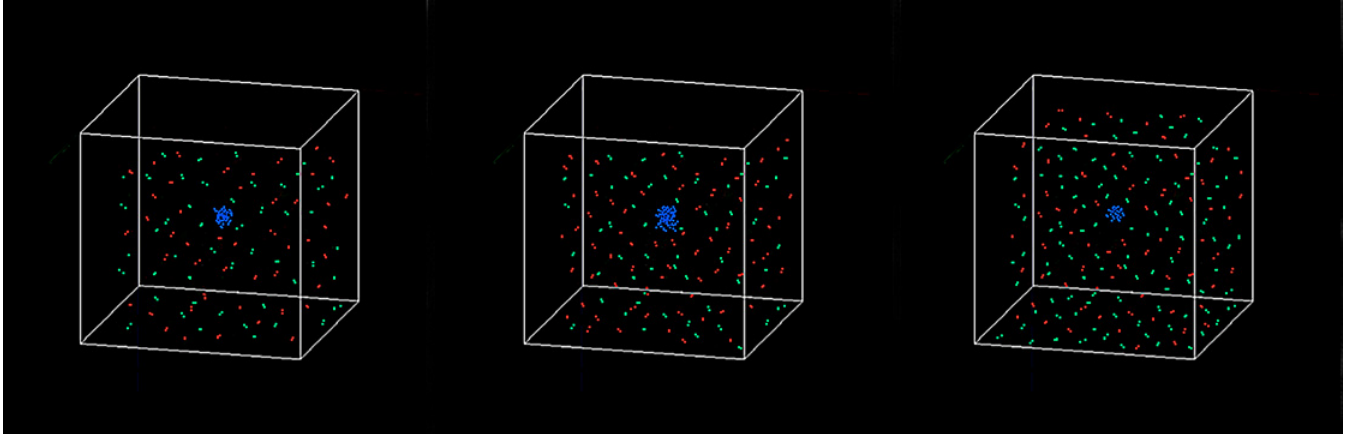
Fig 13. 3D snapshots of the tumor system with single-agent Lidamycin treatment at (a) time step 65, (b) time step 70 and (c) time step 85.